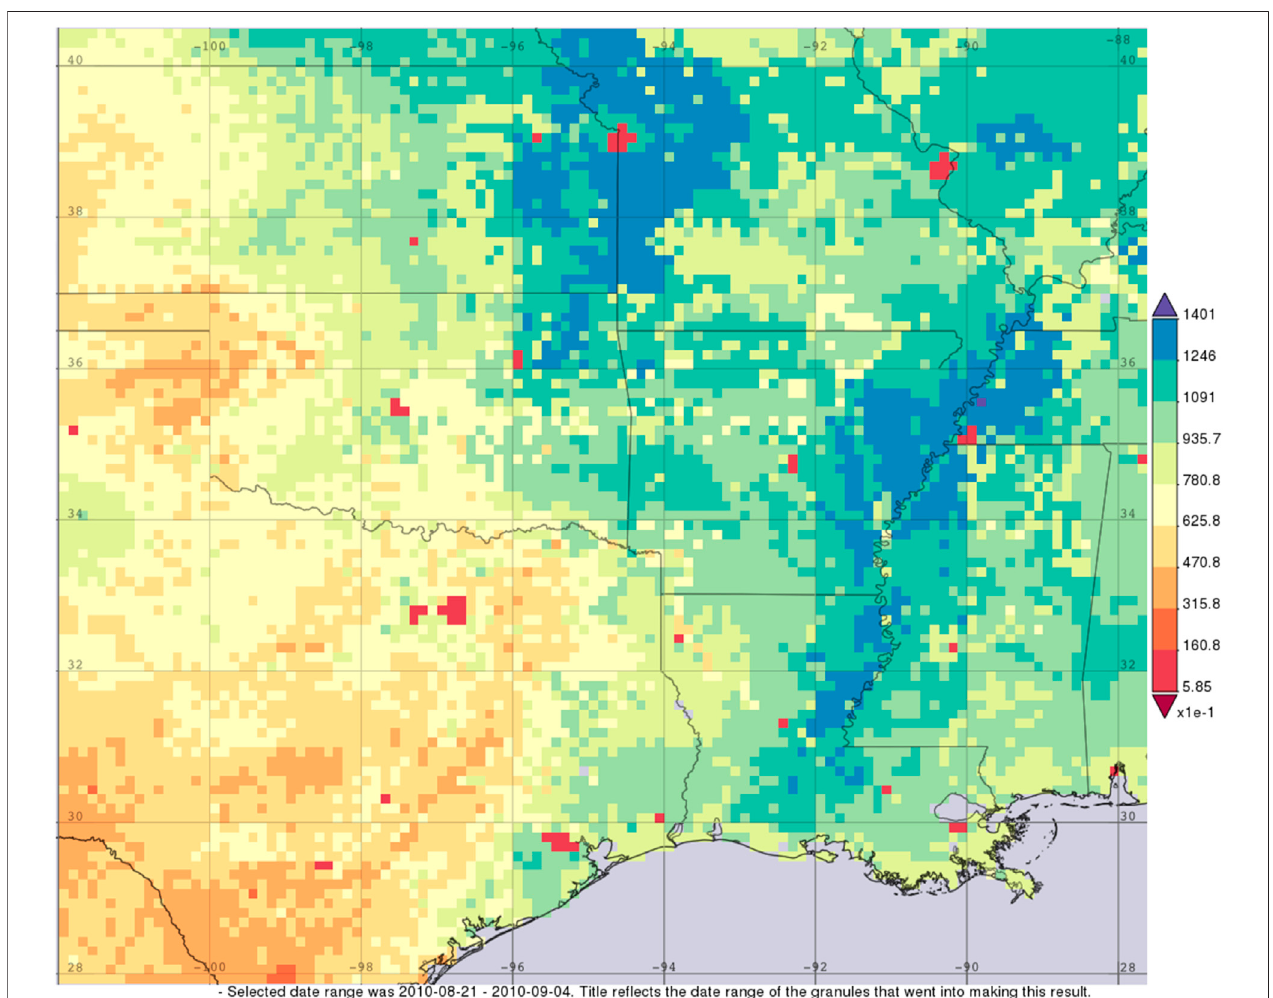
FIGURE 13 | Time-averaged net latent heat fl ux from the NCA-LDAS model in W m − 2 . Source: NASA GIOVANNI.